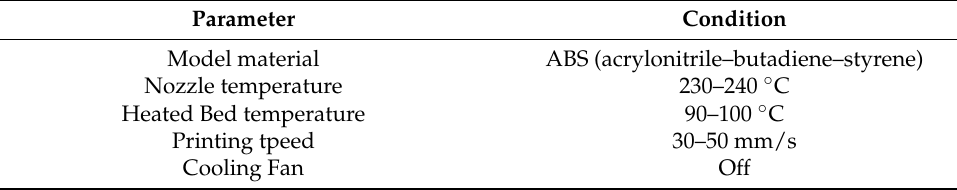
Table 1. 3D-printing